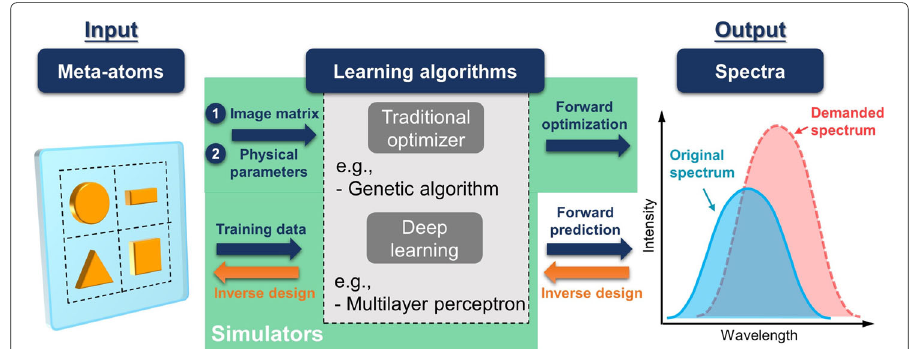
Fig. 2 Spectral tuning for meta-atoms. The dark blue and orange arrows with texts represent the close interplays among three parts of the schematics, namely, meta-atoms (left, as input), learning algorithms (middle) and spectra (right, as output). Left: four typical geometric shapes of meta-atoms situated on a substrate. Middle: the traditional optimizer (e.g., GA) versus deep learning model (e.g., MLP of deep neural network). Right: spectrum modifications from the original line-shape in blue towards the target response in red. Note that the layout of mete-atoms could be represented as image matrices (see Fig. 3) or physical parameter vectors (see Figs. 4 & 5) for the further treatment in the learning